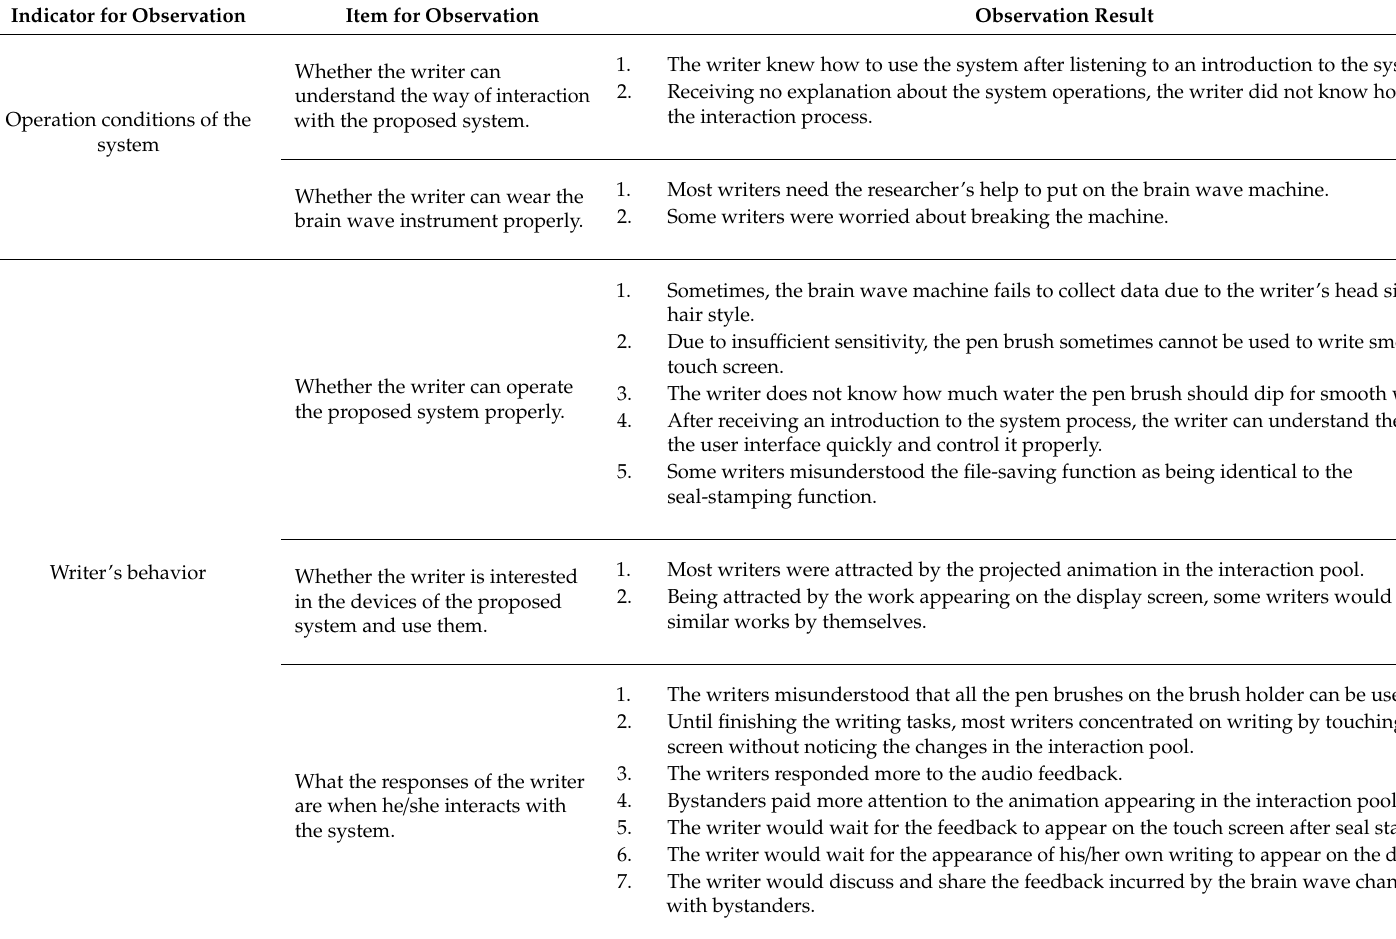
Table 8. Observation results collected from the public exhibition of the first